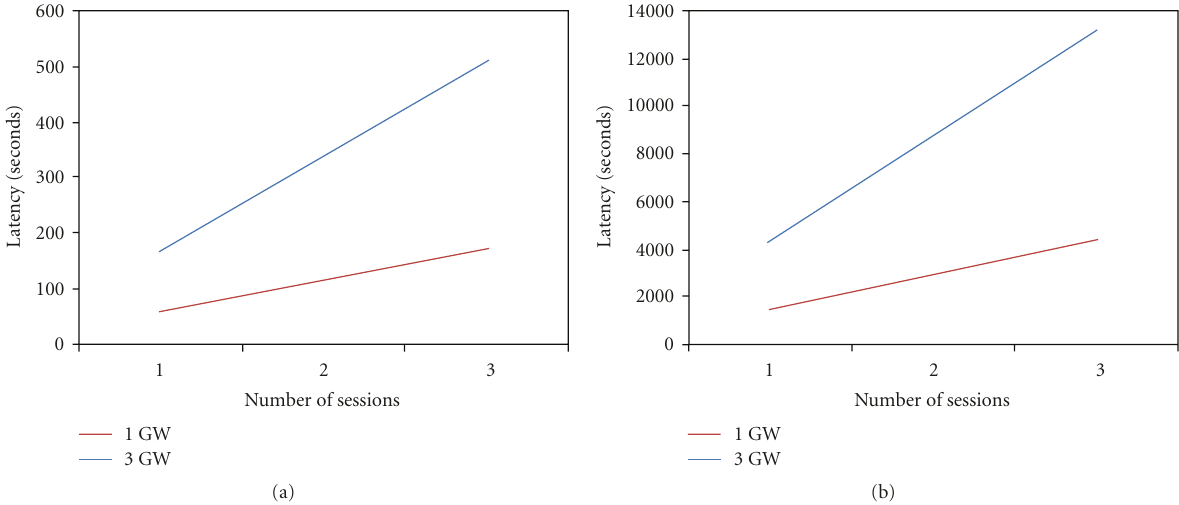
Figure 14: E ff ect of background tra ffi c for file sizes (a) 5Kbytes and (b)